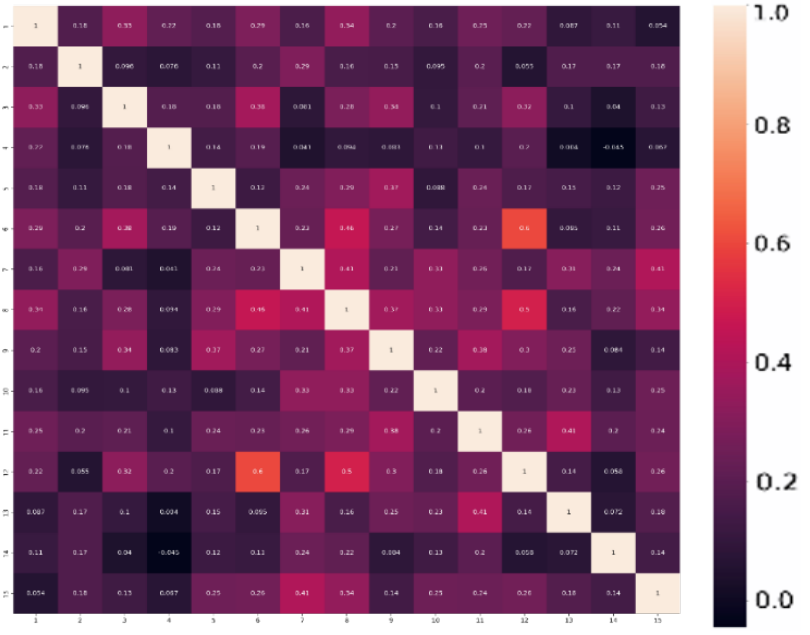
Figure 5. Correlation matrix of 15 stocks.